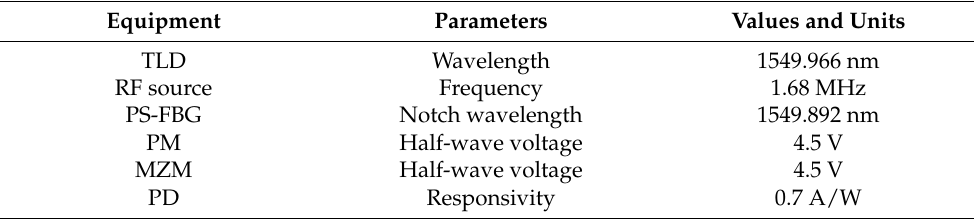
Table 1. Device parameters in the